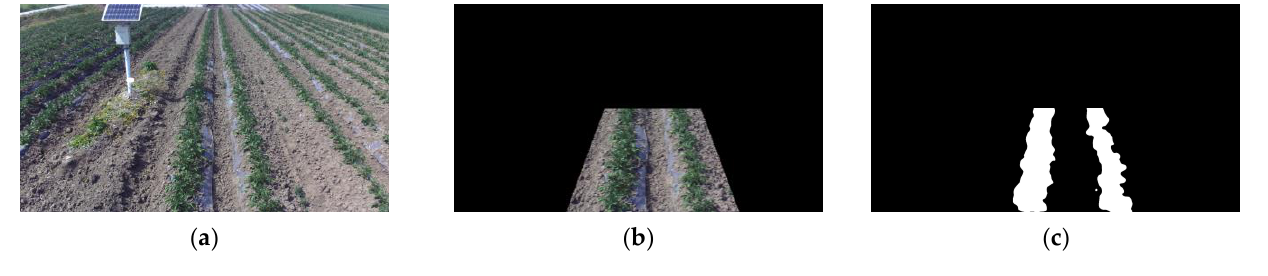
Figure 6. Data augmentation: ( a ) original image; ( b ) counterclockwise rotation 45°; ( c ) clockwise rotation 45°; ( d ) horizontal mirror; ( e ) vertical mirror; ( f ) brightness adjustment; ( g ) contrast adjust- ment.